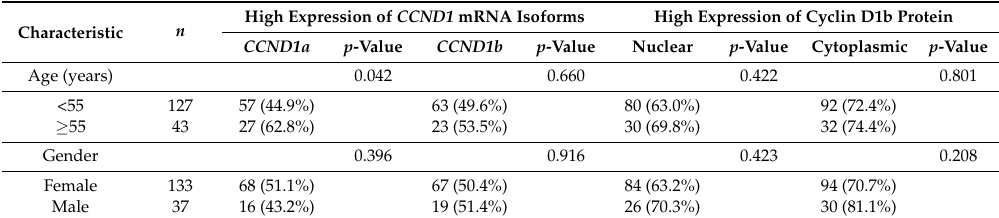
Table 2. Correlation between clinicopathologic features and expression of CCND1 mRNA isoforms and cyclin D1b protein in 170 patients with papillary thyroid carcinoma. AJCC: American Joint Committee on Cancer.